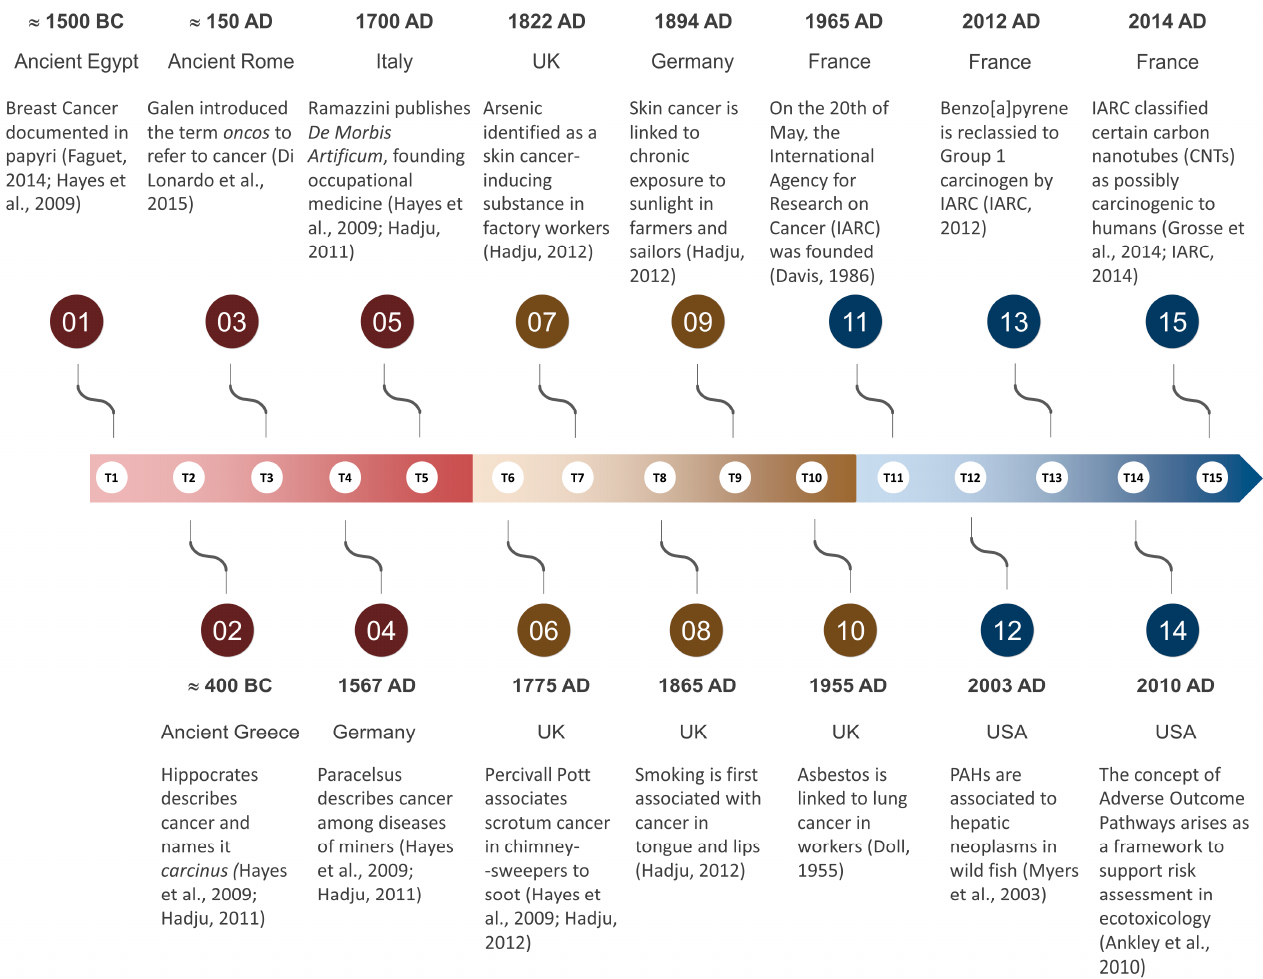
Figure 1. Important milestones in ‘oncotoxicology’, from the first written records to modern days. Main sources [2,19,21,23–32] are indicated as per reference list.